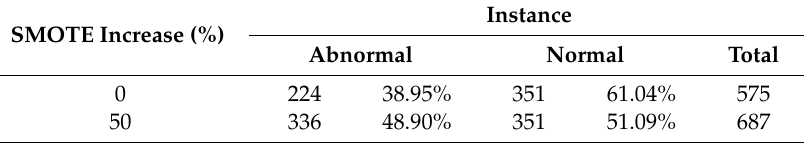
Table 3. SMOTE effect.